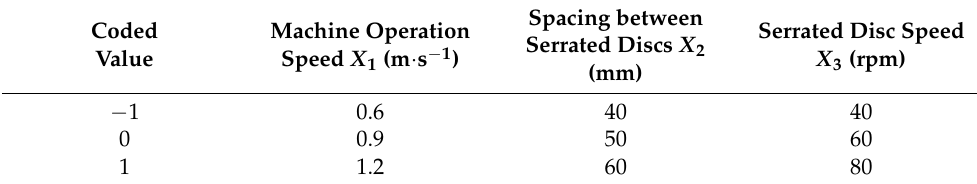
Table 3. Test factors and levels.